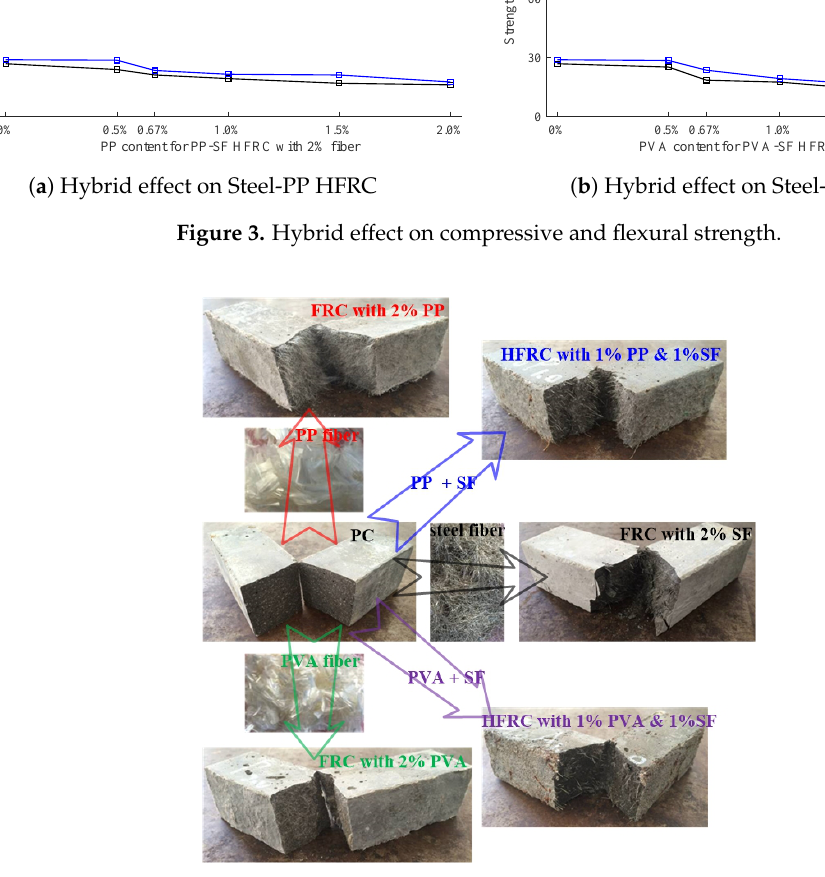
Figure 4. Specimens after